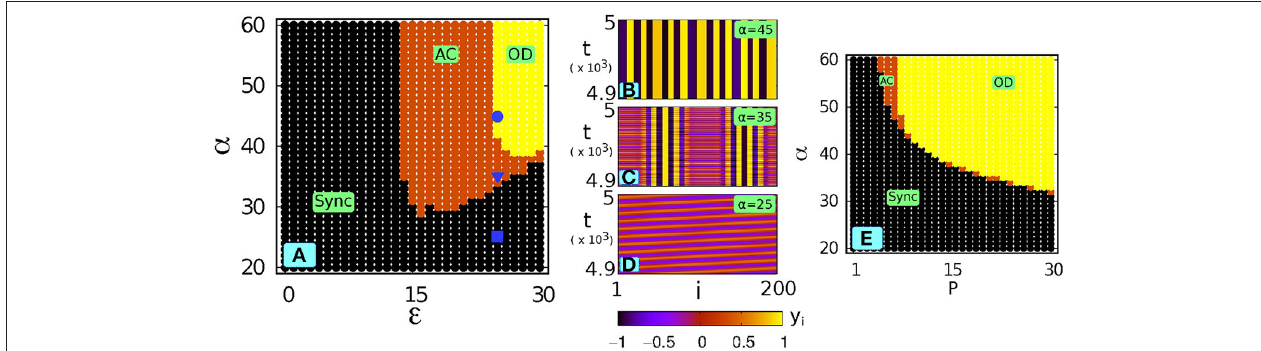
25 are marked by =